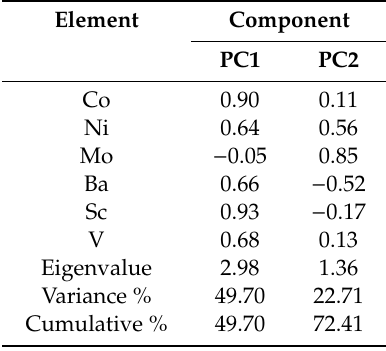
Table 4. Principal component analysis (PCA) of heavy metals.